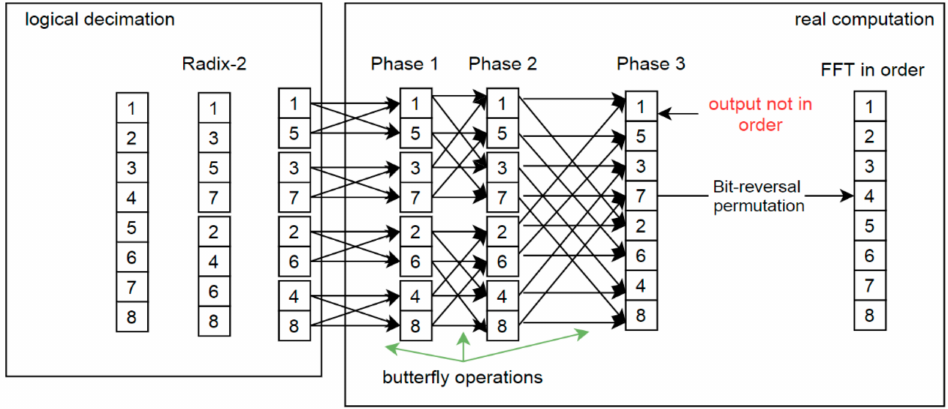
Figure 1. Fast Fourier Transform and bit-reversal permutation; indices division on the left; merge phase on the right side; final computation requires reordering to obtain expected